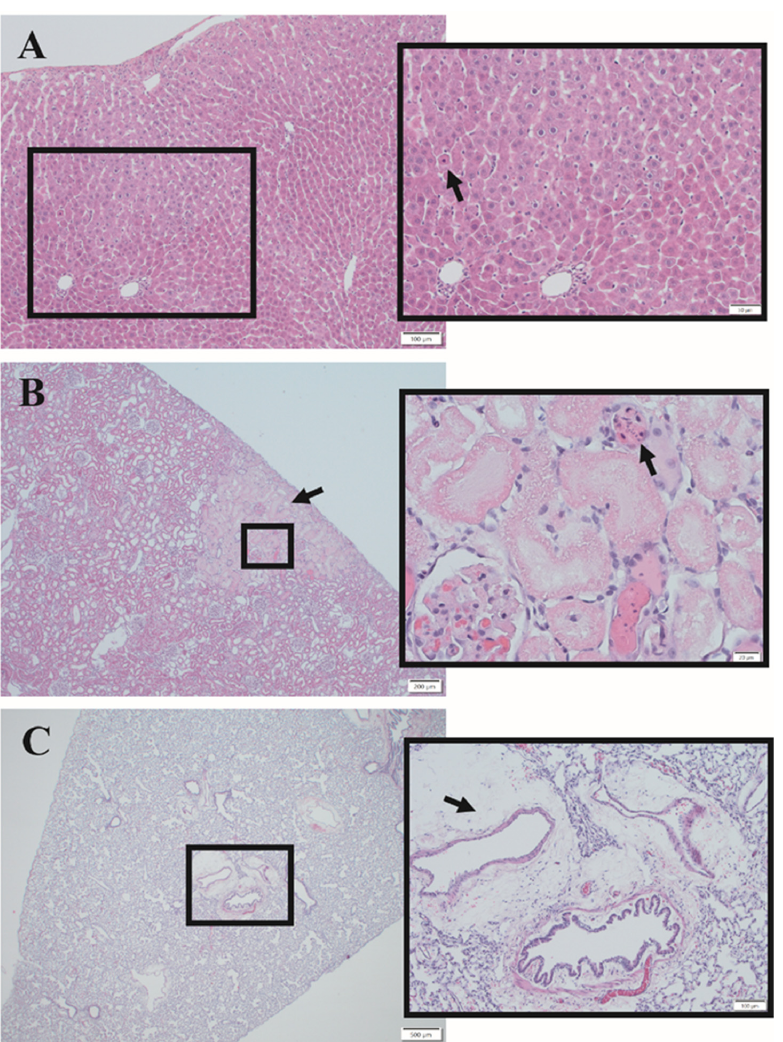
Figure 4. Hematoxylin and eosin histology Images. Representative images show histological findings in the ( A ) liver, ( B ) kidney, and ( C ) lung. Hepatocellular degeneration was observed in the liver with an arrow pointing to a necrotic hepatocyte in the control resuscitative fluid group ( A ). A focally extensive area of necrosis is indicated by the arrow. Renal tubular coagulative necrosis and rare lytic necrosis were observed as shown in the inset from the control resuscitative fluid group ( B ). Additional observations included intratubular casts of mucoprotein and glomerulus with marked mesangial and endocapillary fibrin, edema, and congestions admixed with increased hypercellularity, which is indicative of glomerulonephritis. Perivascular and vascular changes were observed in the lung for both groups; the image is from the T-101 group ( C ). The arrow points to mild to moderate multifocal perivascular edema. The inset shows one bronchiole and several large arterioles with moderate perivascular edema. Scale bars = ( A ) 100 µ m, 50 µ m; ( B ) 200 µ m, 20 µ m; ( C ) 500 µ m, 100 µ